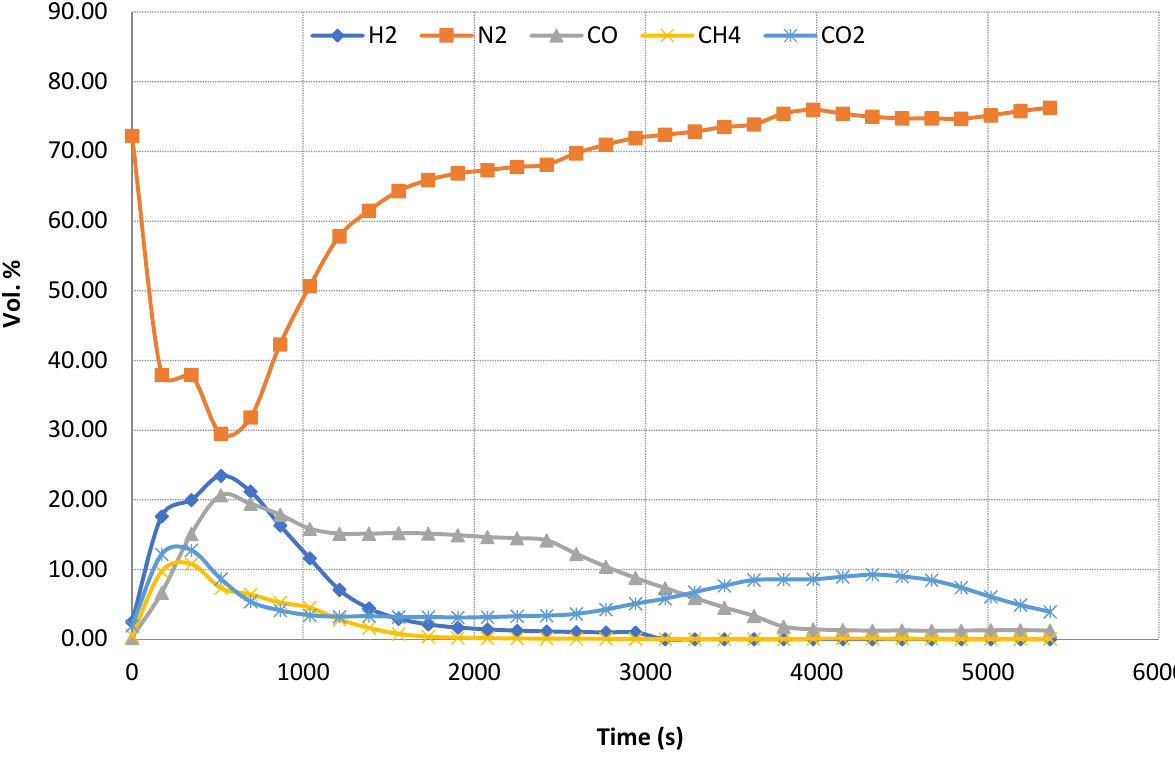
Figure 4. Time dependence of gas composition at 900 °C.